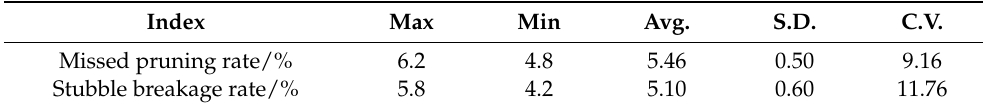
Table 6. Results of field test.